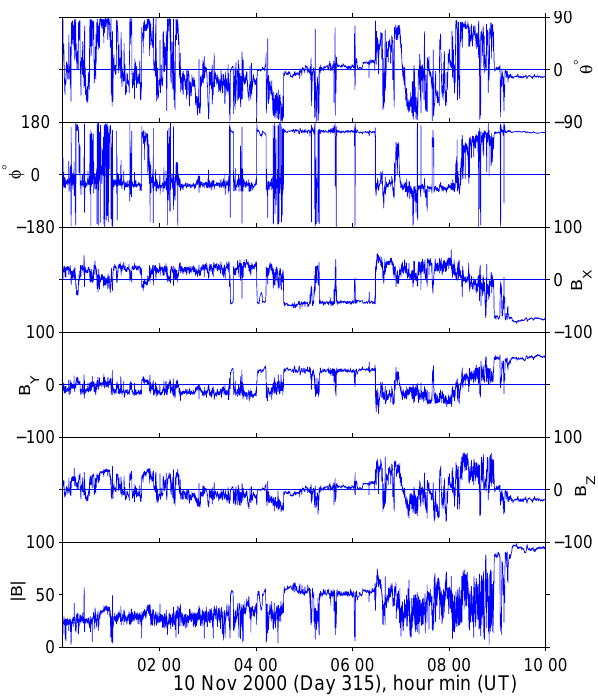
Fig. 1. Spin averaged magnetic field data in GSE coordinates from Cluster 4 recorded between 00:00 and 10:00 UT on 10 November 2000 (day 315). Panels show magnetic field elevation and longitude angles in degrees, the three components and the magnitude in